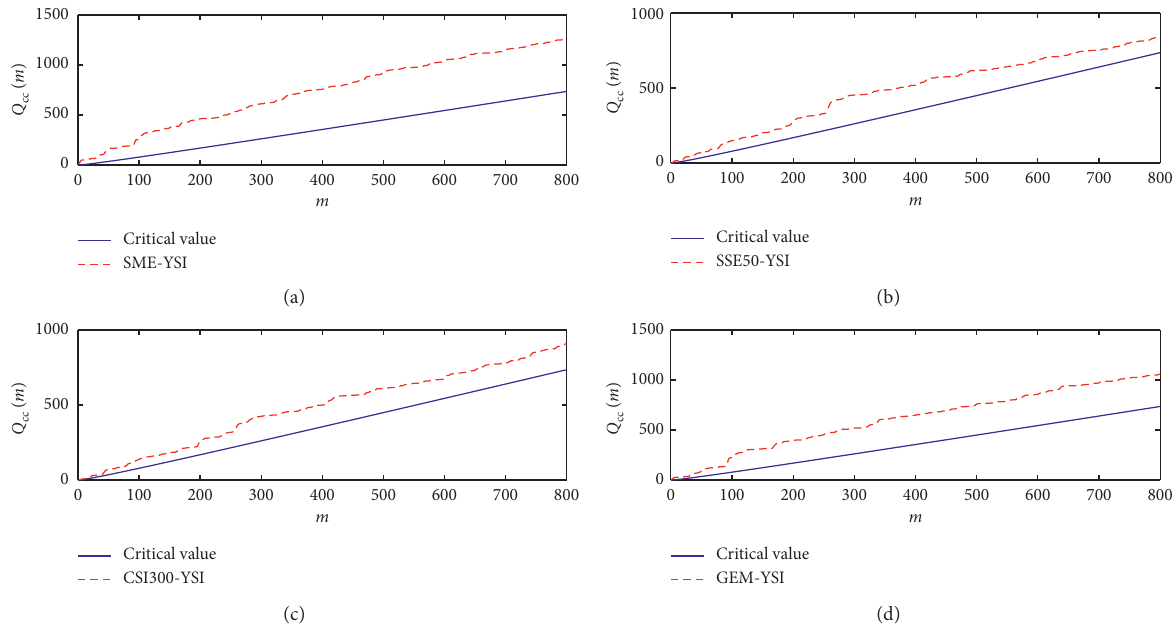
Figure 3: The cross-correlation statistic Q